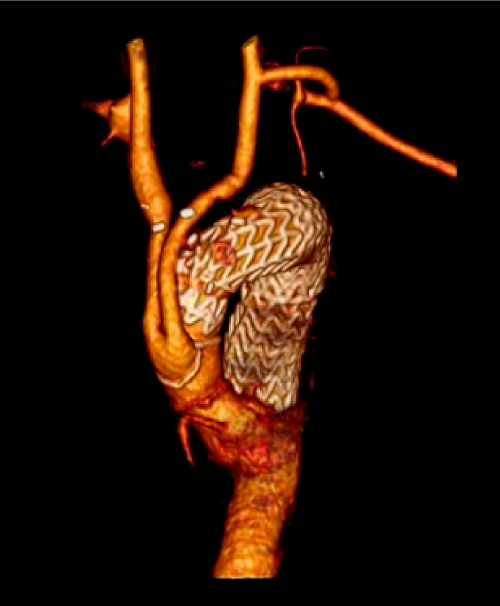
Figure 4. 3 years follow-up type II debranching CT scan.